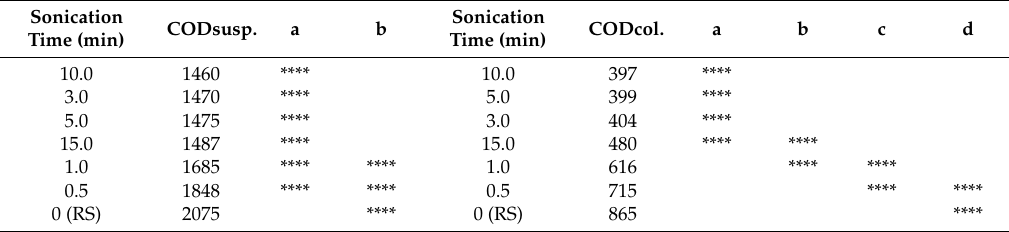
Figure 4 . Impact of sonication time on the COD profile (graph with results of statistical analyses— one-way ANOVA). Table 4. Results of Tukey HSD test for CODsusp; CODcol (cells marked with stars and same letters in the table are not significantly different according to the carried out Tukey test, ( p > 0.05)).